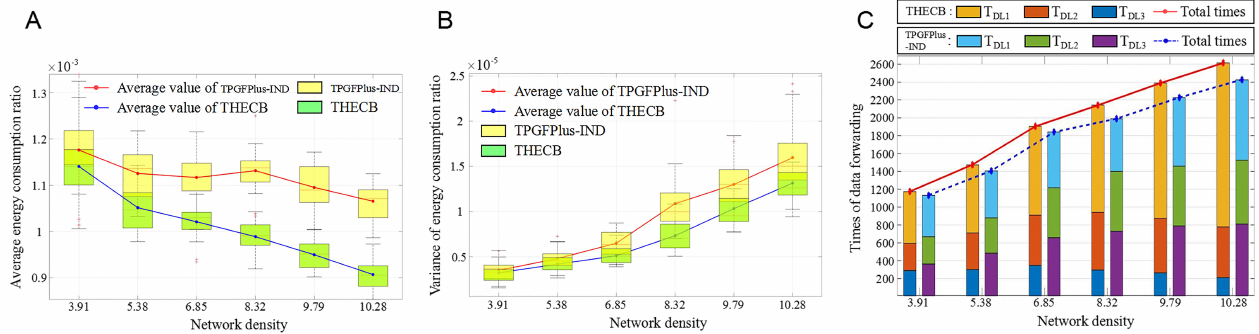
Figure 16. The performance of these algorithms with varied network densities. ( A ) Average energy consumption ratio. ( B ) Variance of energy consumption ratio. ( C ) The times of participating in data